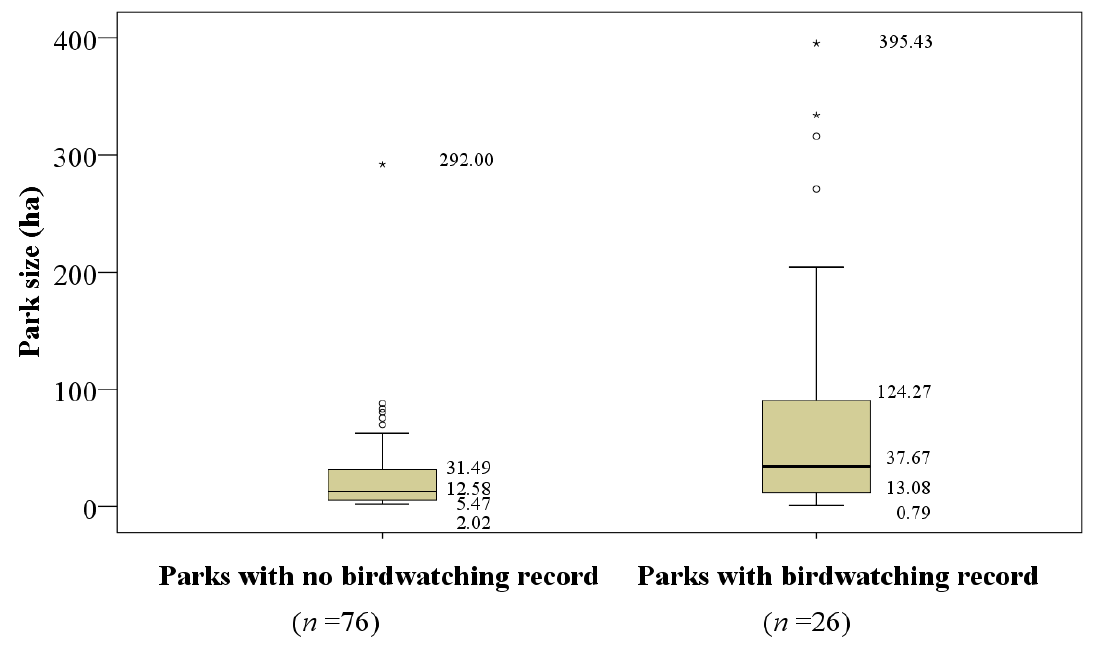
Figure 5. Comparisons of park size with / without birdwatching records. Notes: park with no birdwatching, n = 76, park size mean = 24.87 (ha), park with birdwatching, n = 26, park size mean = 86.37 (ha).